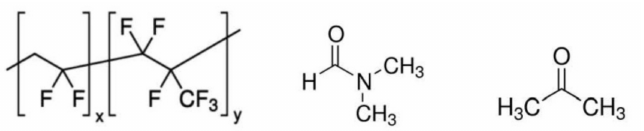
Figure 1. Chemical structures (from left to right) of PVDF- co -HFP, DMF and